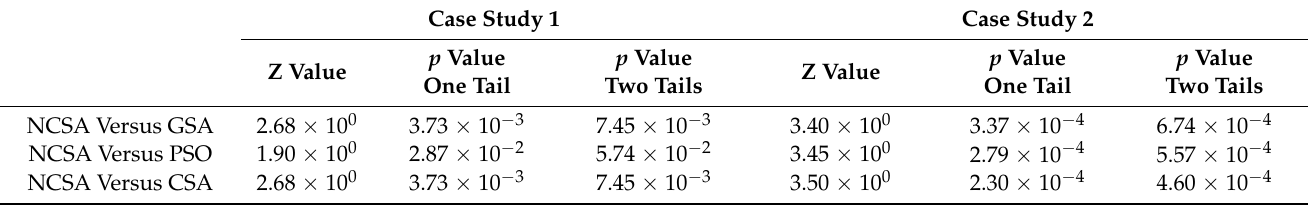
Table 7. Statistical data of applied metaheuristic algorithms on well placement optimization for case study 2. Table 8. Statistical data of applied metaheuristic algorithms on well placement optimization for the case study 1